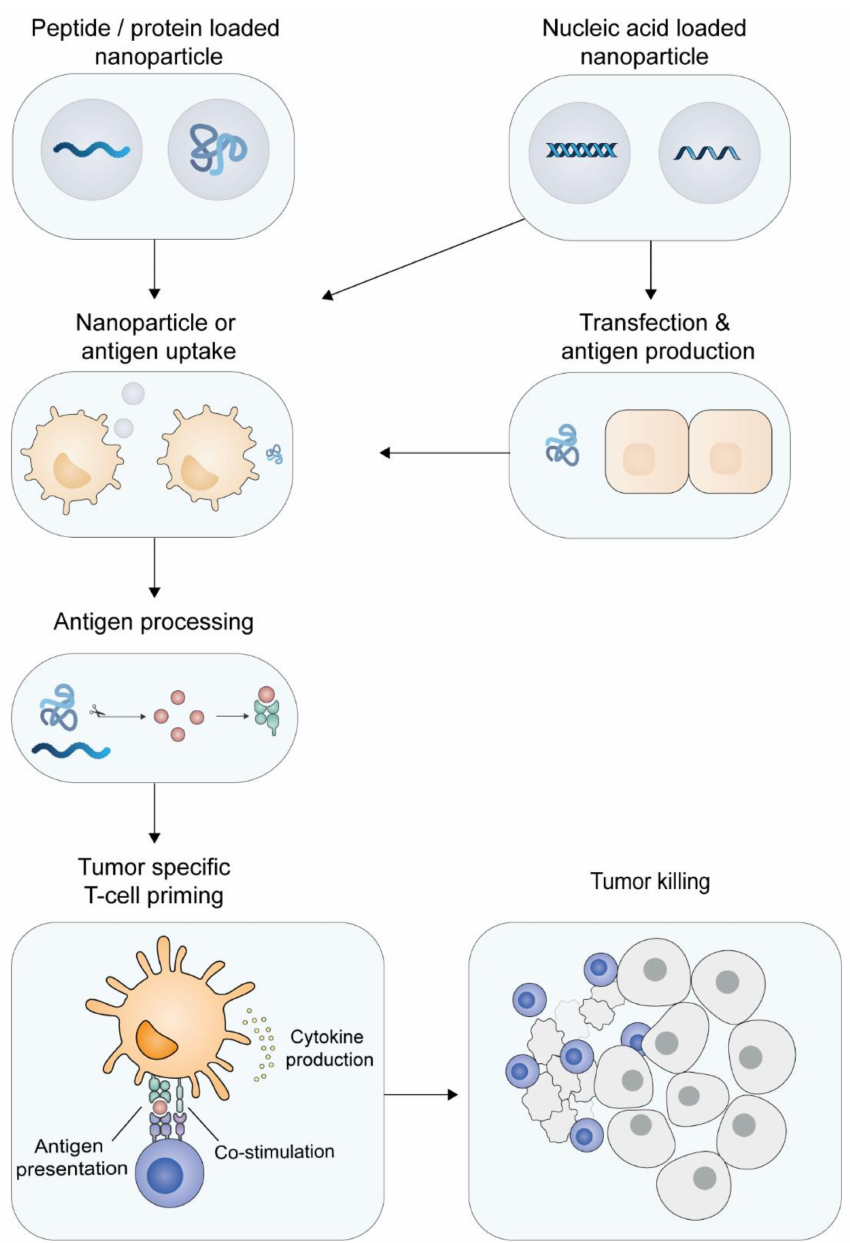
Figure 2. Priming of tumor-specific T-cells. Dendritic cells can engulf synthetic peptide- or protein- loaded cationic nanoparticles and subsequently process the particles. Nucleic acid-loaded particles can also transfect non-immune cells (like epidermal or muscle cells) that, upon transcription and translation, produce antigenic proteins, which are subsequently taken up by DCs. The antigen is processed and the tumor-specific epitopes are presented by the DC to CD8 + T-cells (cross-presentation) or to CD4 + T-cells. In combination with immune stimulation, the DCs upregulate co-stimulatory molecules and produce pro-inflammatory cytokines, resulting in priming of tumor-specific T-cells. The activated tumor-specific T-cells are able to home to the tumor tissue and recognize and kill the malignant